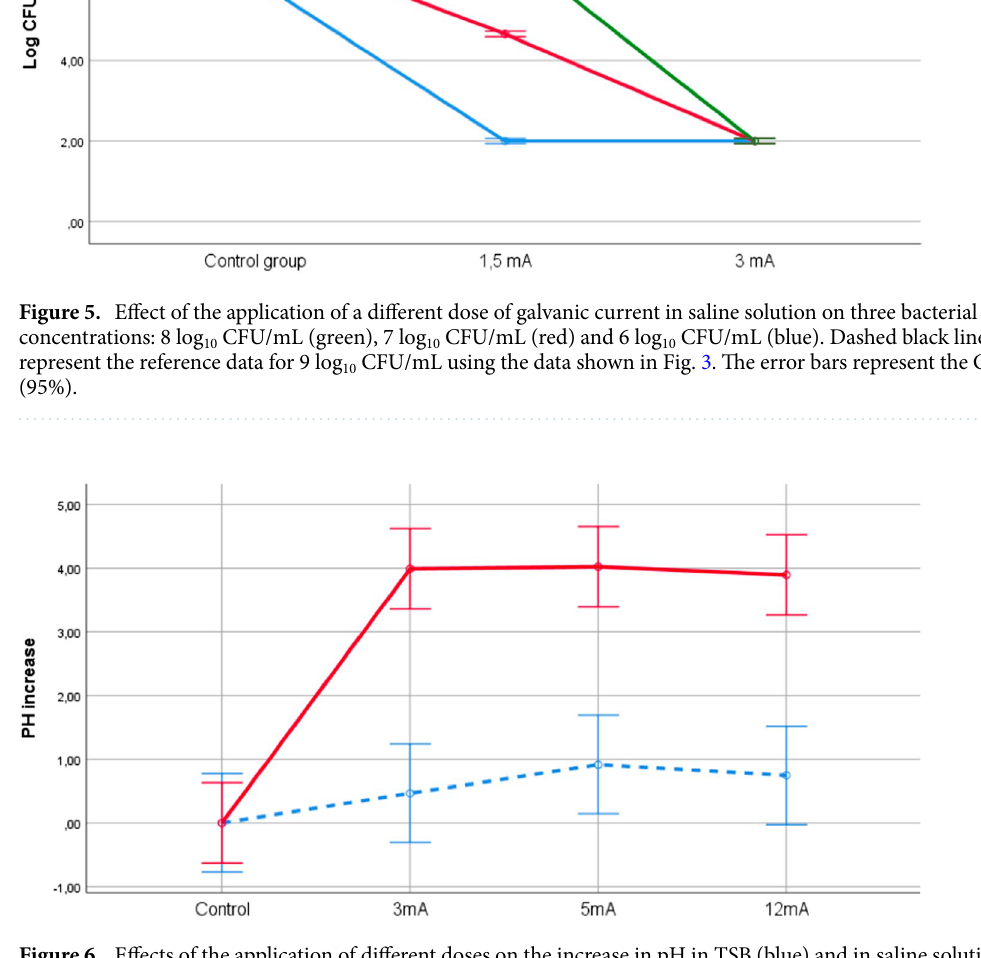
Figure 6. Effects of the application of different doses on the increase in pH in TSB (blue) and in saline solution (red). Baseline pH values had a mean of 6.04 (SD = 0.14) for TSB and 7.1 (SD = 0.07) for saline